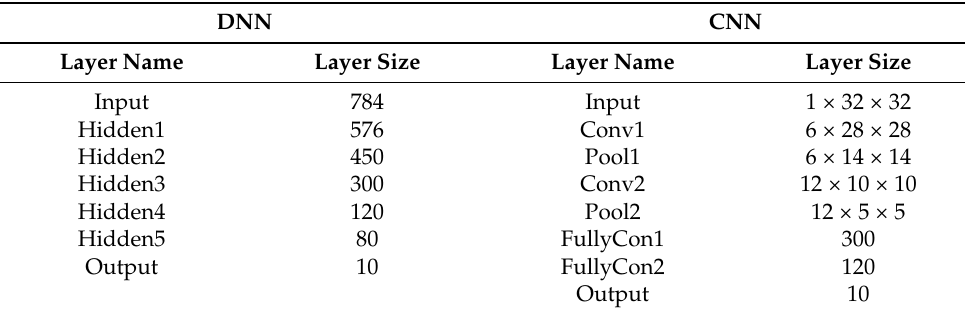
Table 7. Layer names and sizes of DNN and CNN.